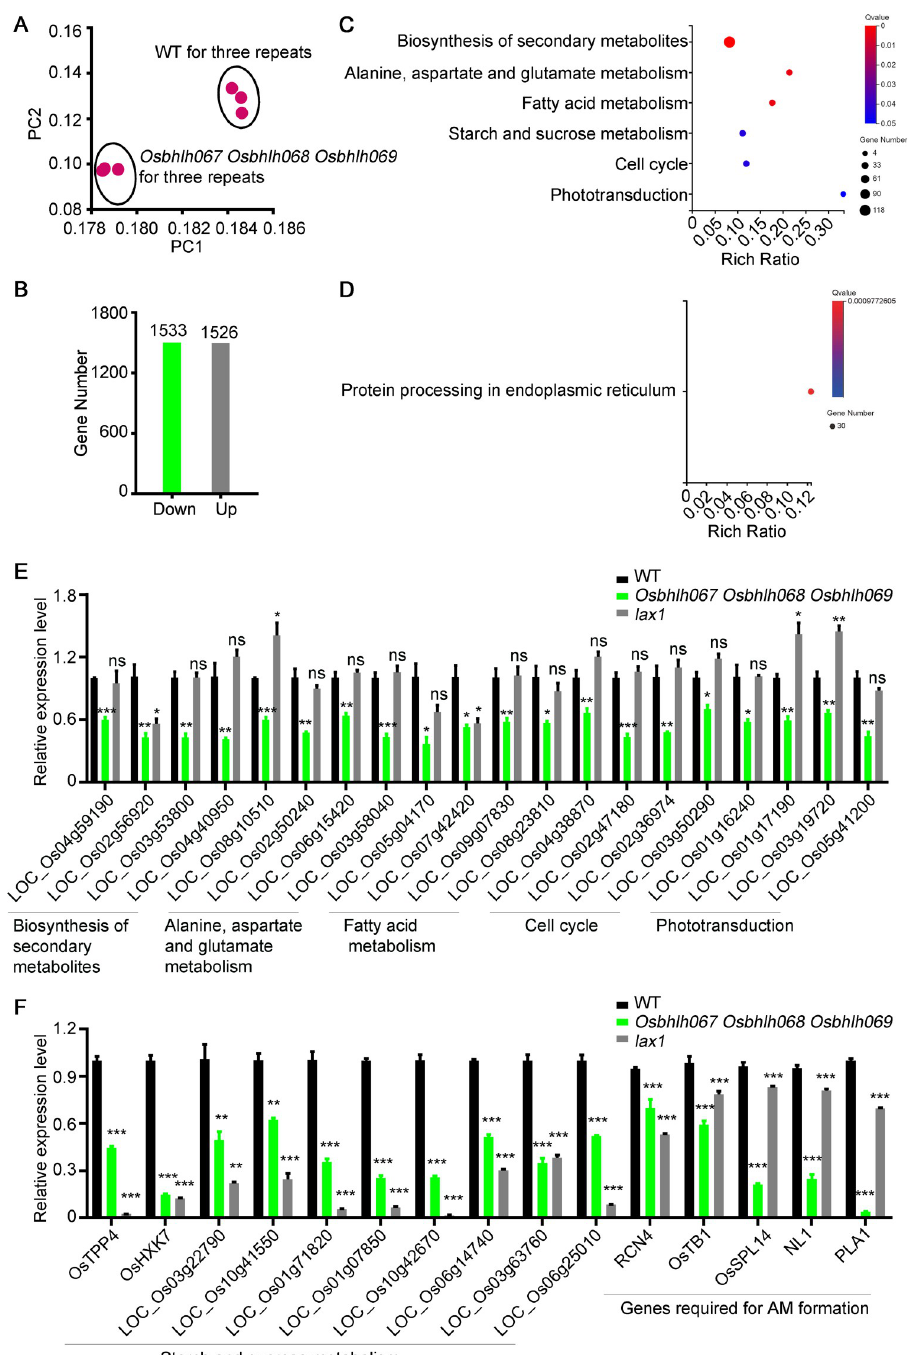
Fig 8. Transcriptome analyses for the Osbhlh067 Osbhlh068 Osbhlh069 triple mutant panicles. (A) Principal component analysis of transcriptome data with three biological replicates in the young panicles ( < 2 mm) of Osbhlh067 Osbhlh068 Osbhlh069 triple mutant. Samples with high similarity will be clustered together. (B) Number of DEGs (Q value � 0.05 and fold change > 1.5) between WT and Osbhlh067 Osbhlh068 Osbhlh069 triple mutant. (C) and (D) Representative KEGG terms (Q value � 0.05) from the down-regulated genes (C) and the up-regulated genes (D) in the Osbhlh067 Osbhlh068 Osbhlh069 triple mutant. (E) Quantitative RT-PCR analysis of genes involved in secondary metabolite biosynthesis, alanine aspartate and glutamate metabolism, fatty acid metabolism, cell cycle, and phototransduction in the Osbhlh067 Osbhlh068 Osbhlh069 triple mutant and lax1 panicles. (F) Quantitative RT-PCR analysis of genes involved in meristem formation and starch and sucrose metabolism for WT and the